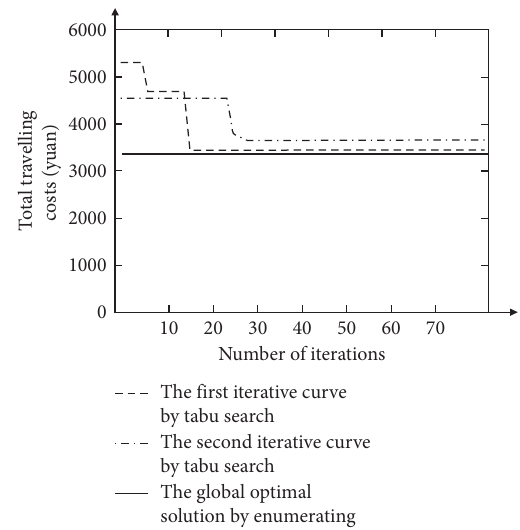
Figure 6: Iterative curves of two optimal solutions’ total traveling